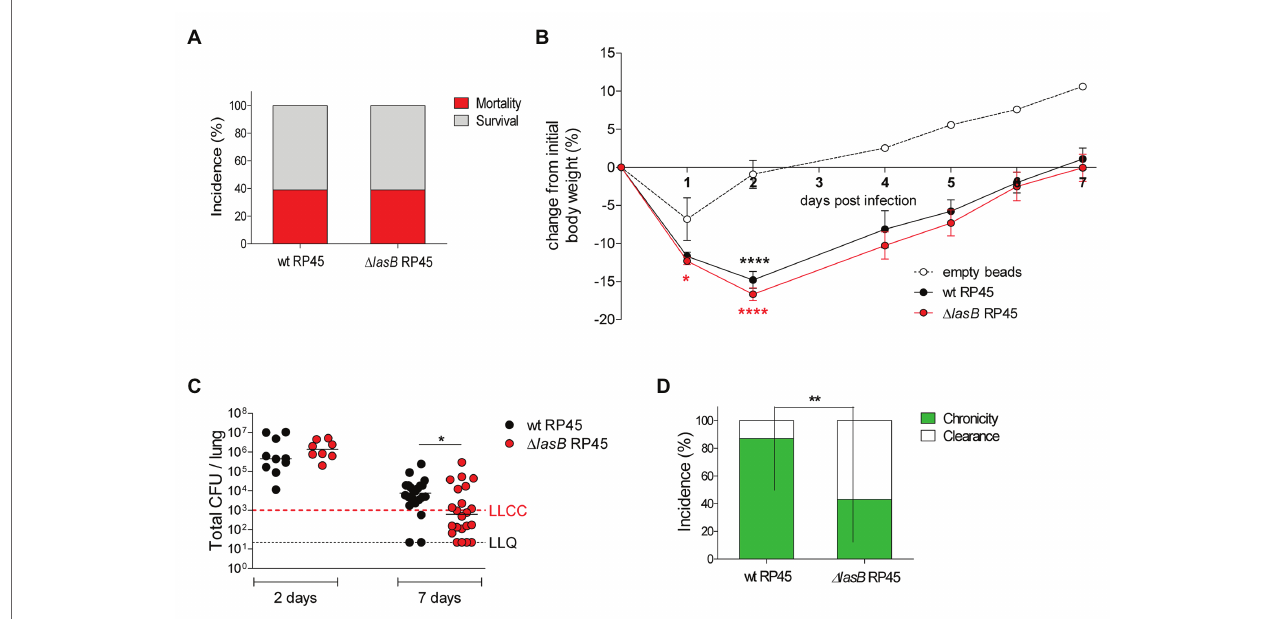
FIGURE 2 | Impact of chronic lung infection by wt and ∆ lasB mutant P. aeruginosa RP45 strains on host response. C57BL/6NCrlBR mice were infected with an average of 5.6 × 10 5 colony forming units (CFUs) embedded in agar beads or with sterile empty beads. Mice were monitored daily for survival and body weight. At Days 2 and 7 post-infection, mice were euthanized, and lungs were excised and homogenized. (A) The incidences of survival and mortality were determined on challenged mice and expressed as percentage. (B) Body weight data are expressed as mean ± standard error of the mean (SEM) of the weight change from the initial body weight. (C) CFUs were evaluated in the lungs after plating onto tryptic soy agar at Days 2 and 7 post-infection. Dots represent values of individual mice, and horizontal lines represent median values. The lower limit of chronic colonization (LLCC) and the lower limit of quantification (LLQ) are indicated. (D) The incidence of clearance (<1,000 P. aeruginosa CFUs in the lung cultures) and capacity to establish chronic airways infection (≥1,000 P. aeruginosa CFUs in the lung cultures) were determined on surviving mice at Day 7 post-infection and expressed as percentage. The data were pooled from three independent experiments (mice nr = 38 per strain). Statistical significance is indicated as follows: * p < 0.05; ** p < 0.01; **** p <